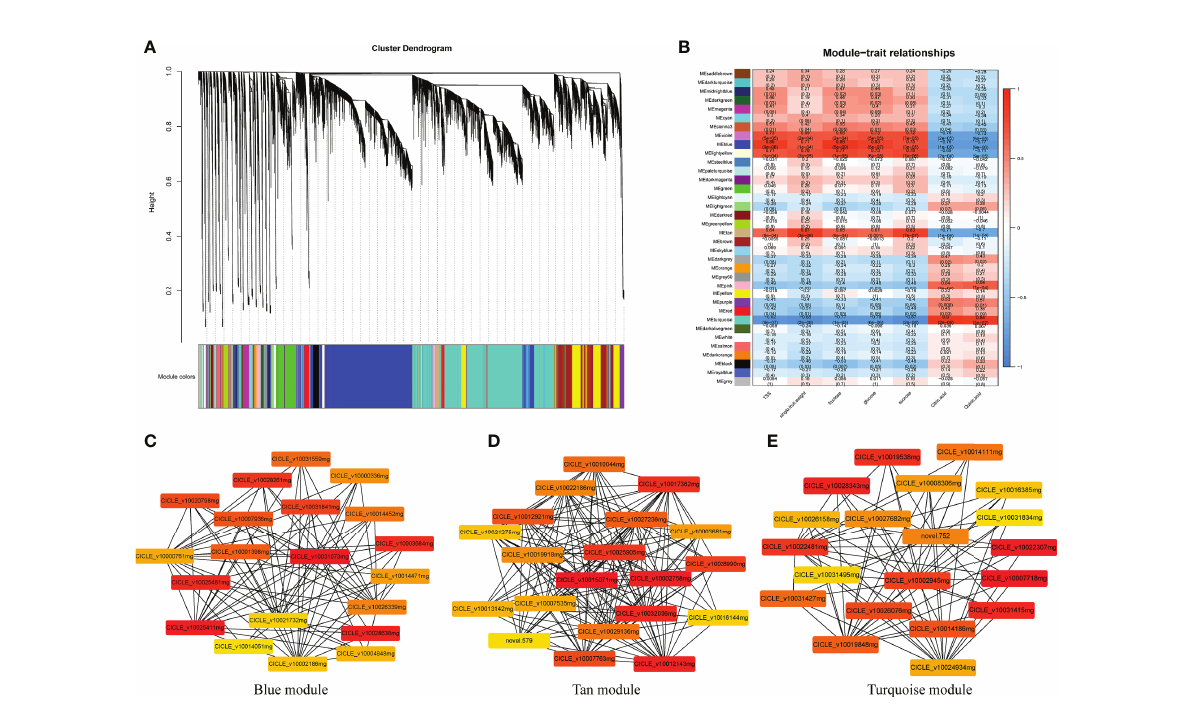
FIGURE 9 Weighted gene co-expression network analysis (WGCNA) of genes identi fi ed in Harumi/Hongjv (HP) and Harumi/Ponkan/Hongjv (HPP) fruits at all four developmental stages. (A) Thirty-six modules of co-expressed genes are shown in a hierarchical cluster tree. A major tree branch represents a module. The modules in the designated colors are shown in the lower panel. (B) Module – trait relationships. The remaining 36 modules are presented in the left panel. The module – trait correlation, ranging from -1 (blue) to 1 (red), is indicated by the color scale on the right. Each column presents the experimental traits, and their associations with each module are represented by a correlation coef fi cient and Pvalue in parentheses. (C) Gene network for the blue module, which positively correlated with TSS, fructose, and glucose. (D) Gene network for the tan module, which positively correlated with single-fruit weight and sucrose. (E) Gene network from the turquoise module, which positively correlated with citric acid and quinic